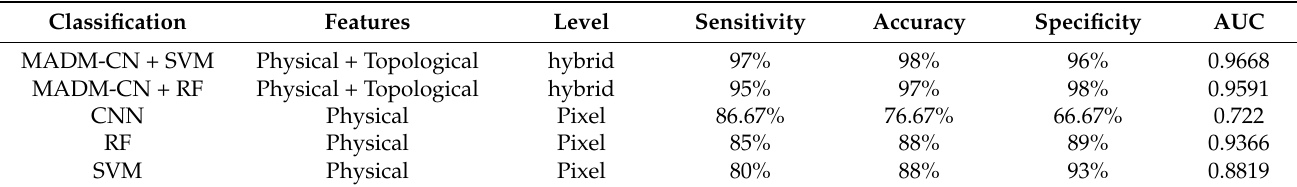
Table 5. Performance compared with the state-of-the-art